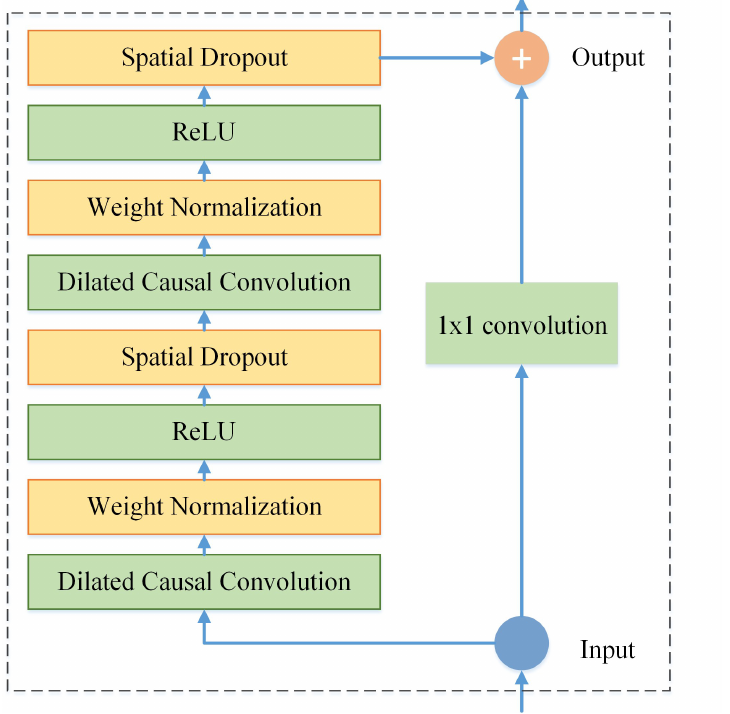
Figure 4. Schematic diagram of residual